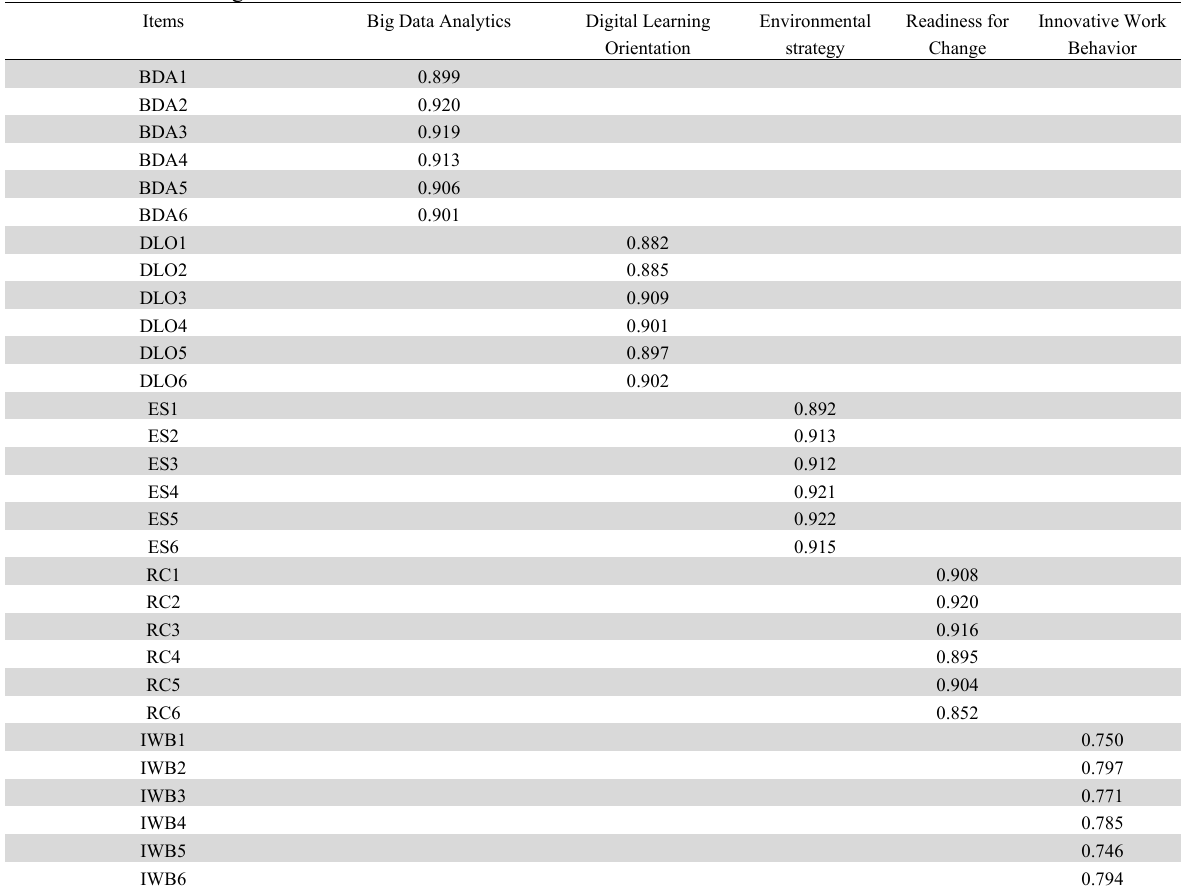
Results of Outer Loading